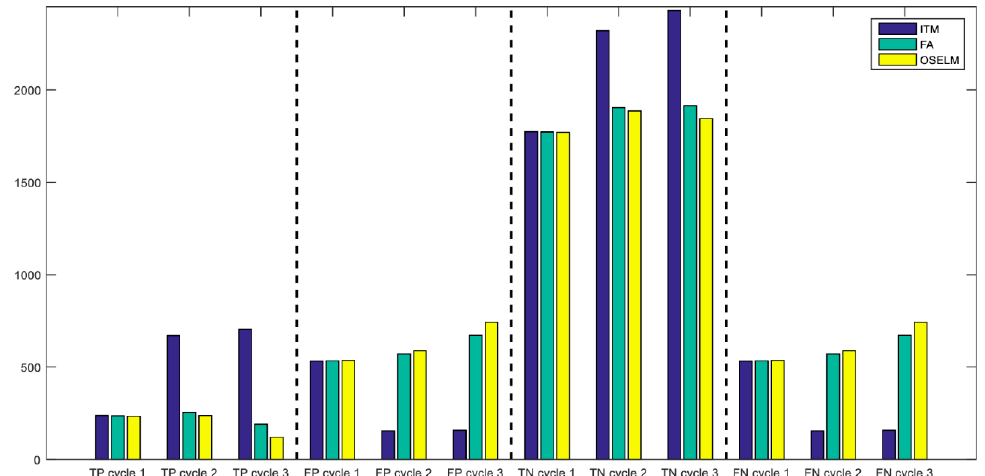
Figure 10. Classification measures with respect to cycles for the three models with the TampereU dataset.